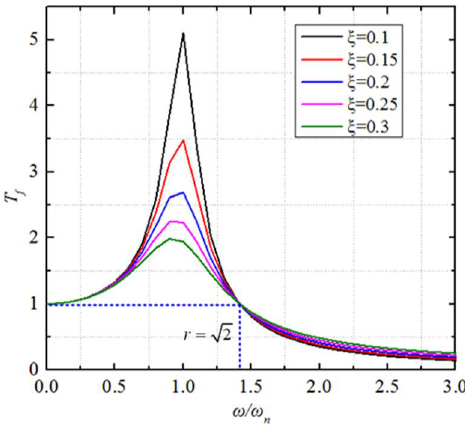
Figure 3. Force transfer coefficient curve.